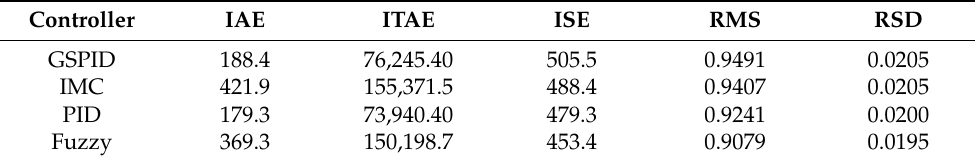
Table 9. Controller performance indexes for a load random disturbance at the tank